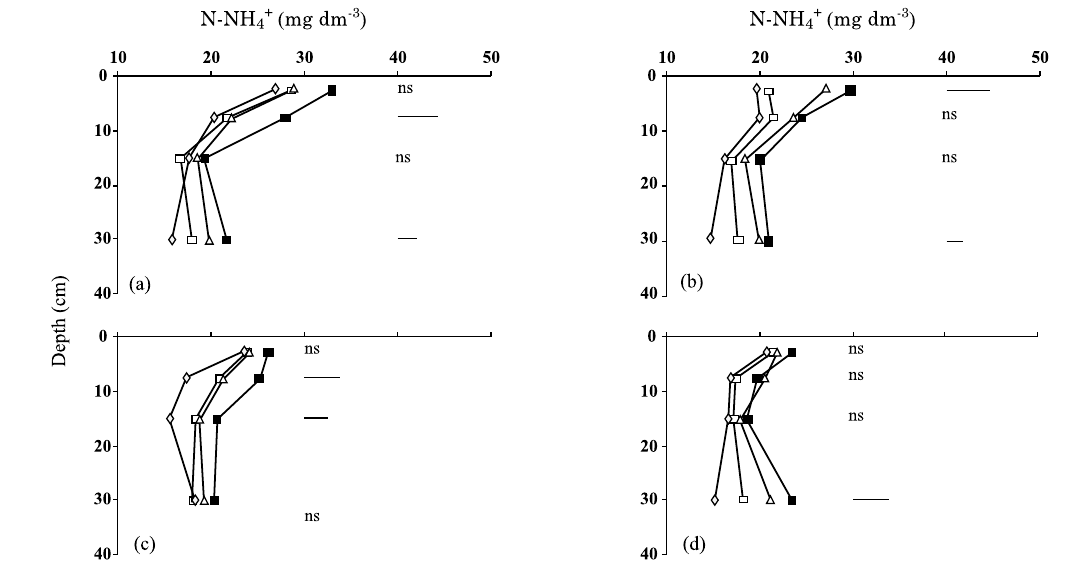
Figure 4. Ammonium (N-NH 4+ ) levels in the soil profile as affected by nitrogen fertilization ( ): 0; ( ): 50; ( ΔΔ ΔΔ Δ ): 100 and ( ): 150 kg ha -1 of N, 18 months after liming ((a): 0; (b): 1500; (c): 3000 and (d): 6000 kg ha -1 of